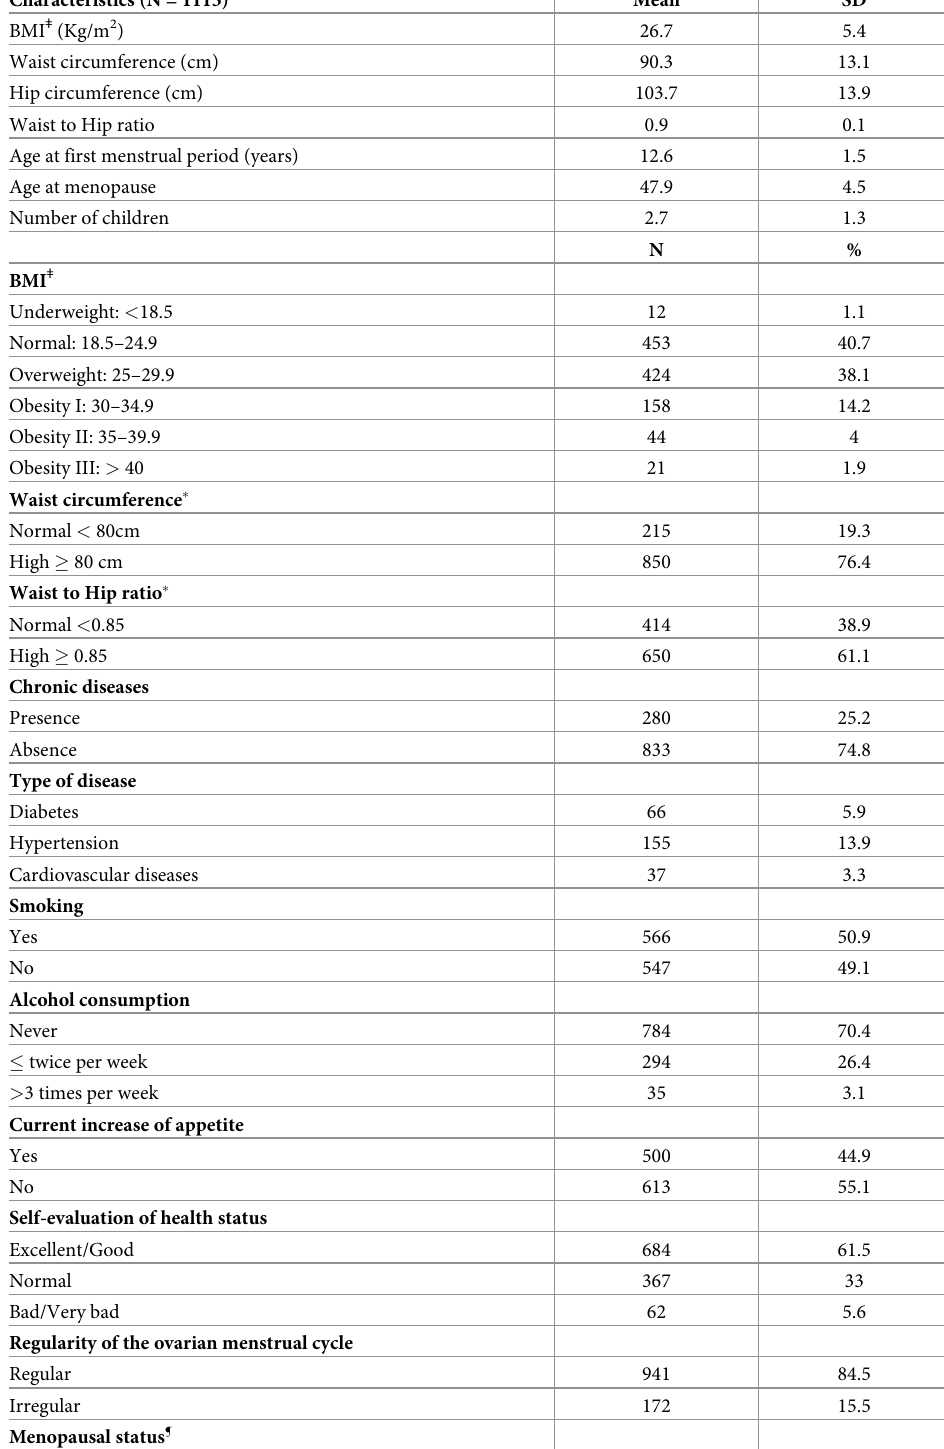
Table 1. Anthropometric measurements, lifestyle, health, menopausal status and mean scores of MENQOL sub- domains of the study